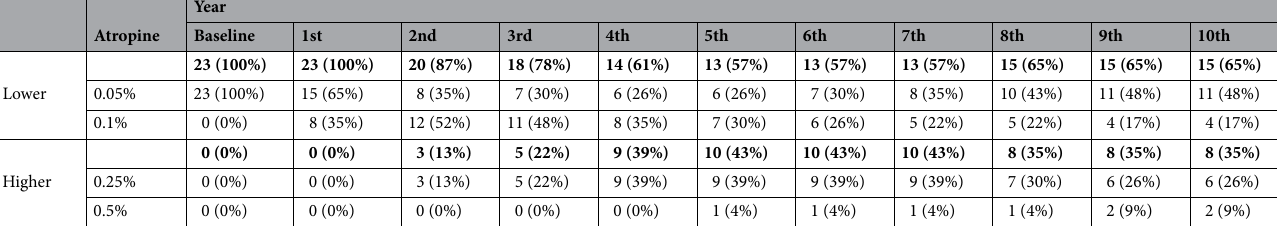
Table 1. The proportion of patients treated with stepwise concentrations of